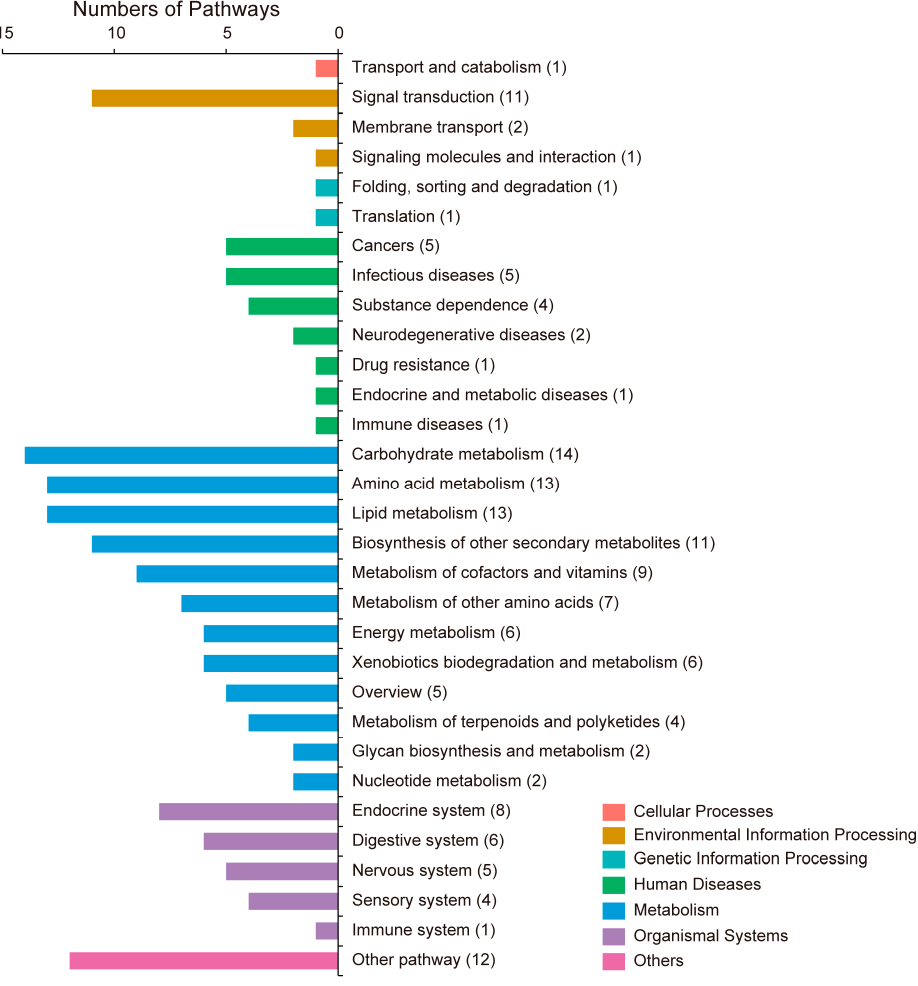
Figure 4. Categories of pathways in which the identified metabolites are involved.